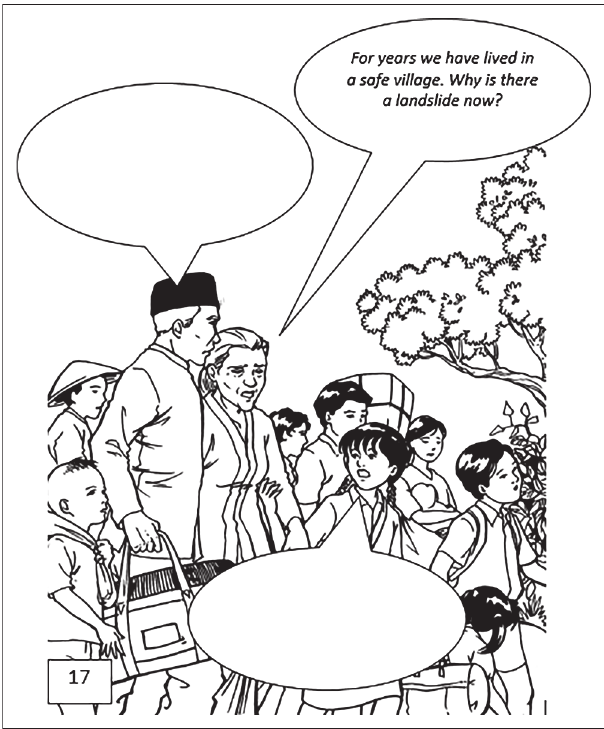
FIGURE 6 : Scene 6 that requires students to analyse the factors that cause landslides. TABLE 5 : Scenes for character values assessment.